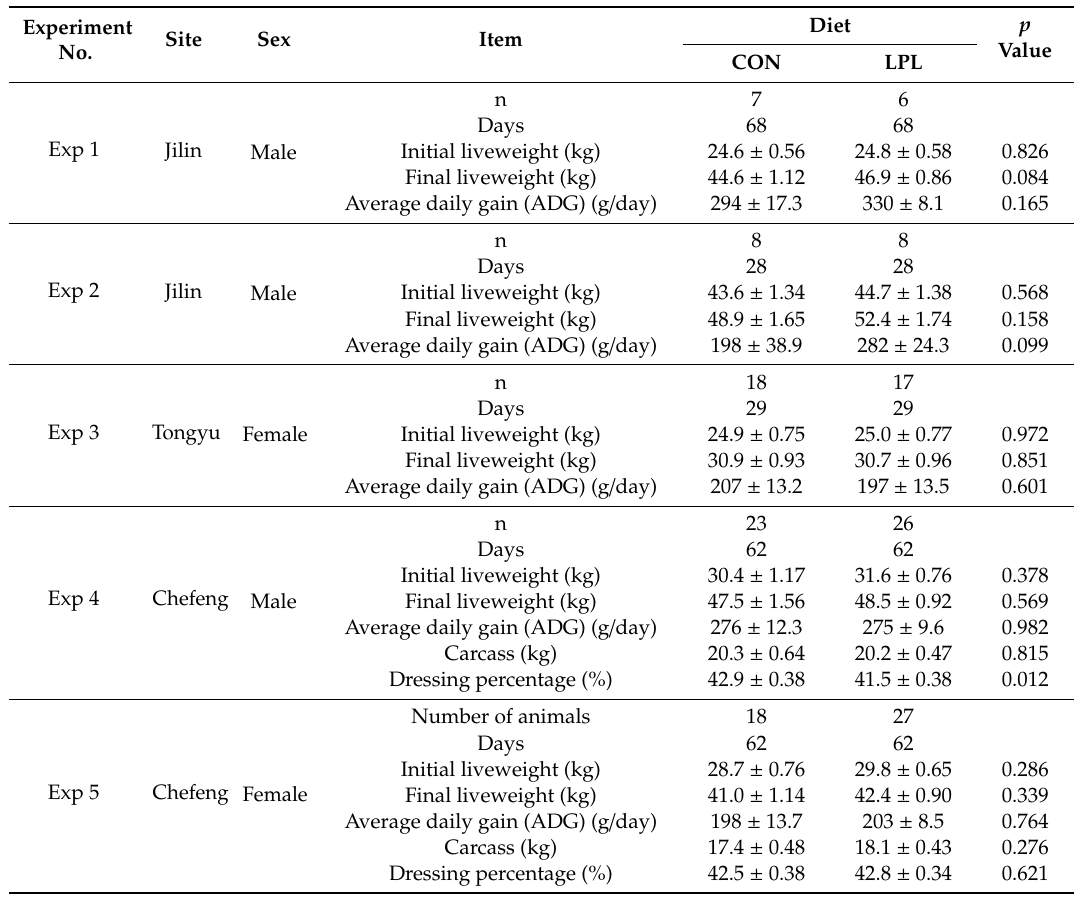
Table 2. Growth performance of fattening lambs fed experimental diets supplemented without (CON) or with (LPL)